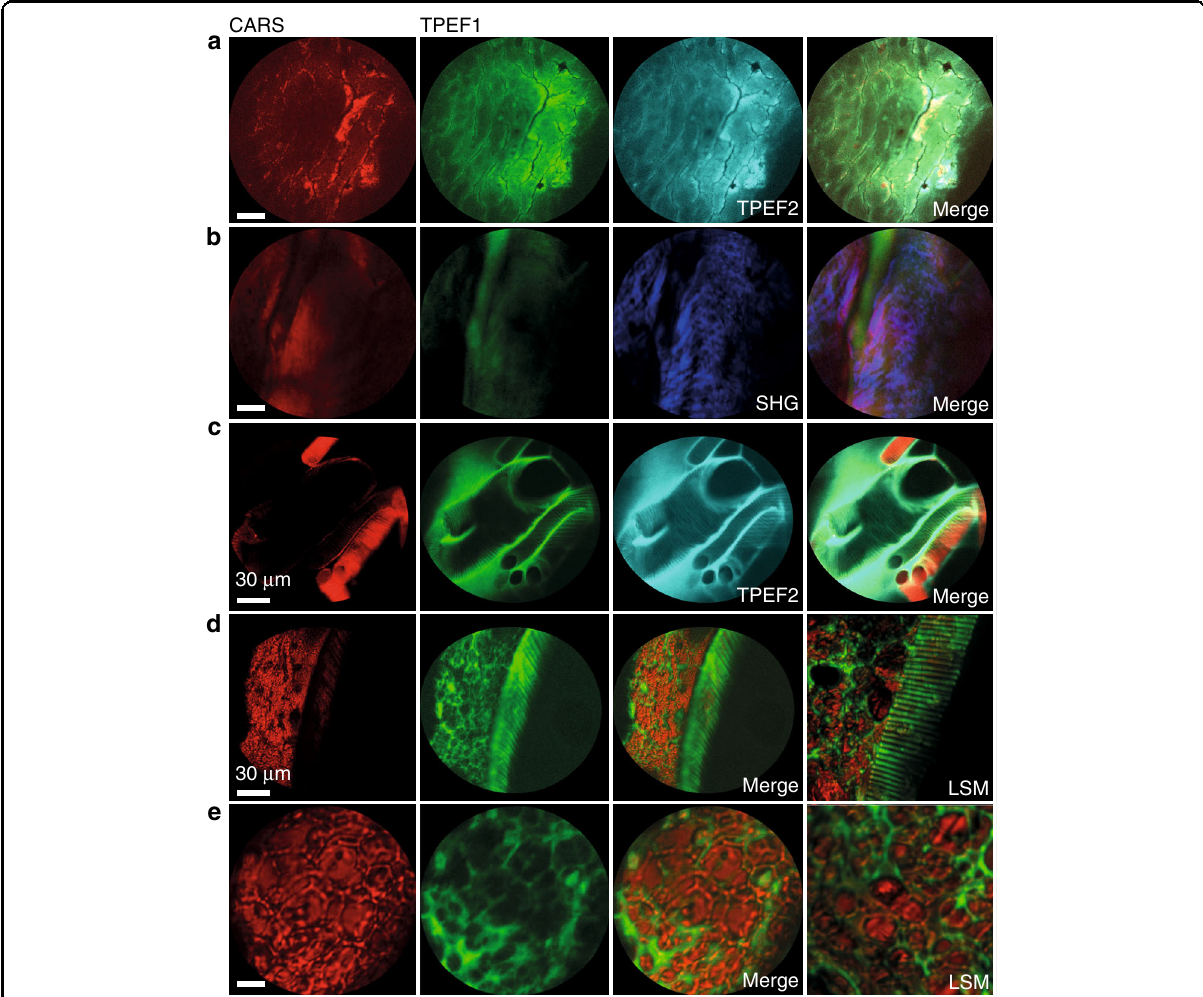
Fig. 5 Multimodal endoscopic images of unstained biological samples ( fi rst column CARS at 2850cm − 1 in red, second column TPEF1 in green, third and fourth columns as indicated). a Human epithelial tissue from the head and neck location CARS, TPEF1, and TPEF2 at 458 nm and combined image, thickness 15 µm. Single epithelial cells and cell nuclei are resolved. b CARS, TPEF, SHG, and combined image of a dura mater section of Ovis aries rich in collagen generating strong SHG signals, thickness 50 µm. c – e CARS, TPEF, and combined images from sections of